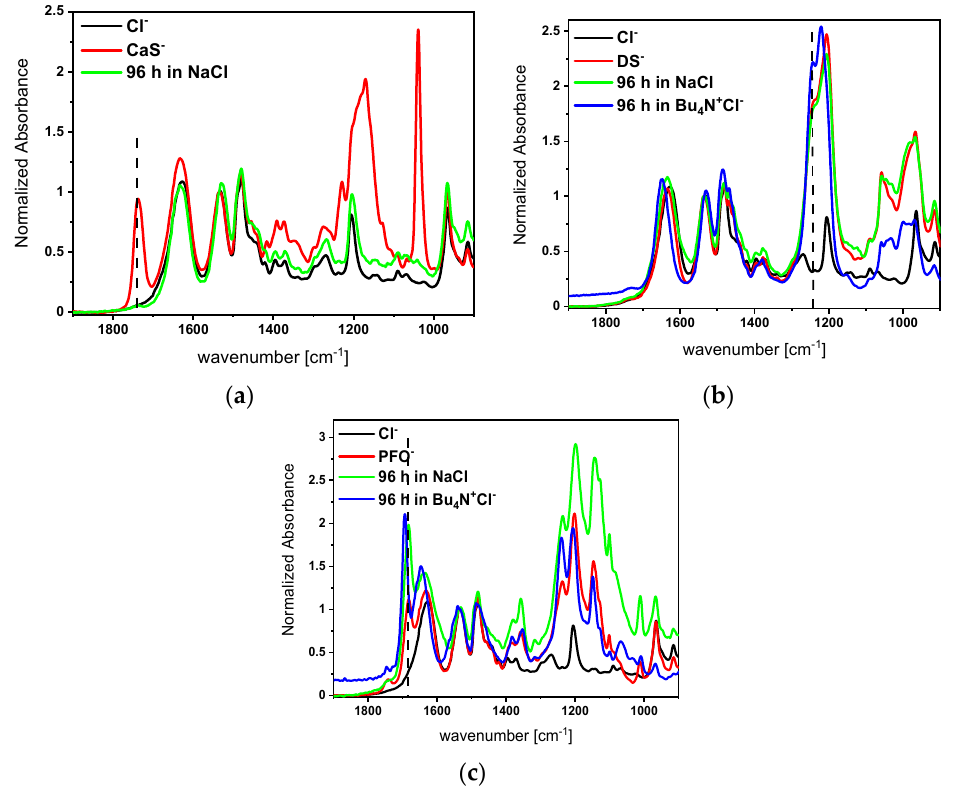
Figure 3. FTIR spectra of the samples attempting a reversible exchange to G1-3-Cl from ( a ) G1-3-CaS, ( b ) G1-3-DS, and ( c ) G1-3-PFO immersed in 3.5 wt% NaCl or Bu 4 N + Cl − solutions. The line indicates the specific absorption band. The spectra were normalized on a polymer gel matrix absorption band at 1535 cm − 1